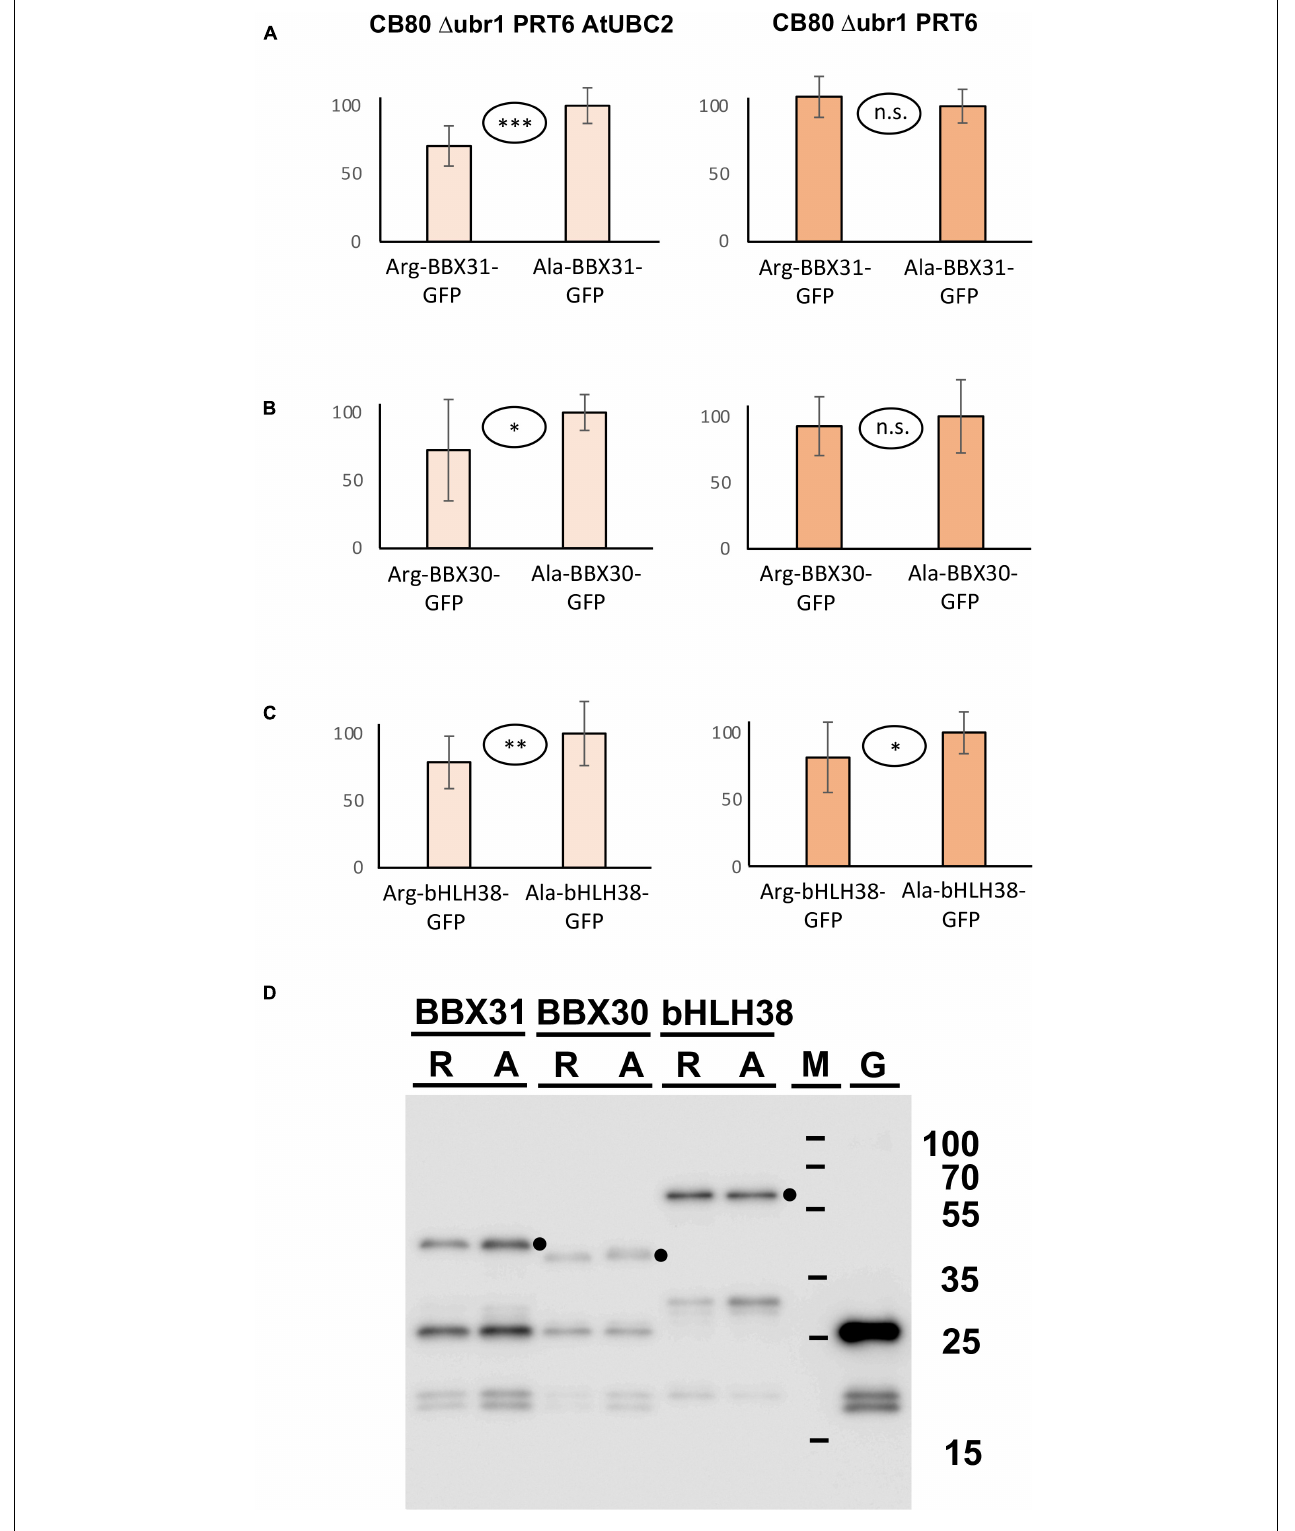
FIGURE 5 | (A–C) Steady-state levels of Arabidopsis proteins BBX31, BBX30, and bHLH38 fused to GFP in different yeast strains. The GFP fusions start either with Arg or with Ala (see Figure 3 and text for amino-terminal processing, and Supplementary File 3 for amino acid sequences). Mean abundance of the protein starting with Ala was set 100%. Standard deviations are shown as error bars. Measurements were carried out 2 h after inoculation of microtiter wells. Plates were